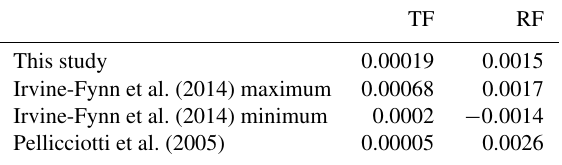
Table 1. Model coefficients obtained using linear regression mod- elling for 14–20 July 2016. Units for TF are meters per hour per degree Celsius (mh − 1 ◦ C − 1 ), and units for RF are meters per hour per megajoule (mh − 1 MJ − 1